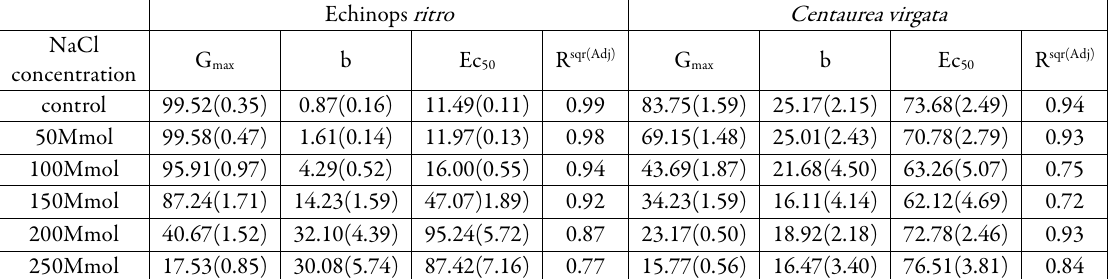
Table 1. The effect of salinity stress on germination of two weeds Echinops ritro and Centaurea virgata Echinops